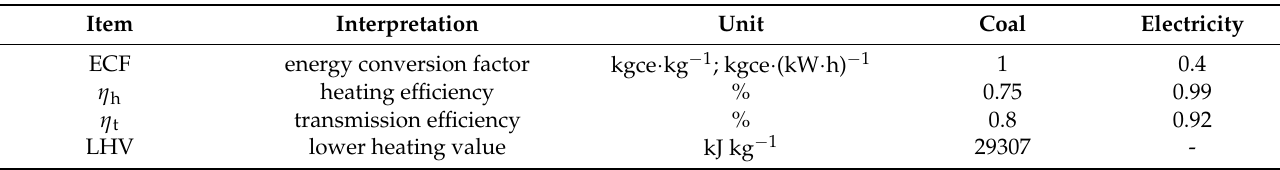
Table 3. Items regarding the PEC calculation.